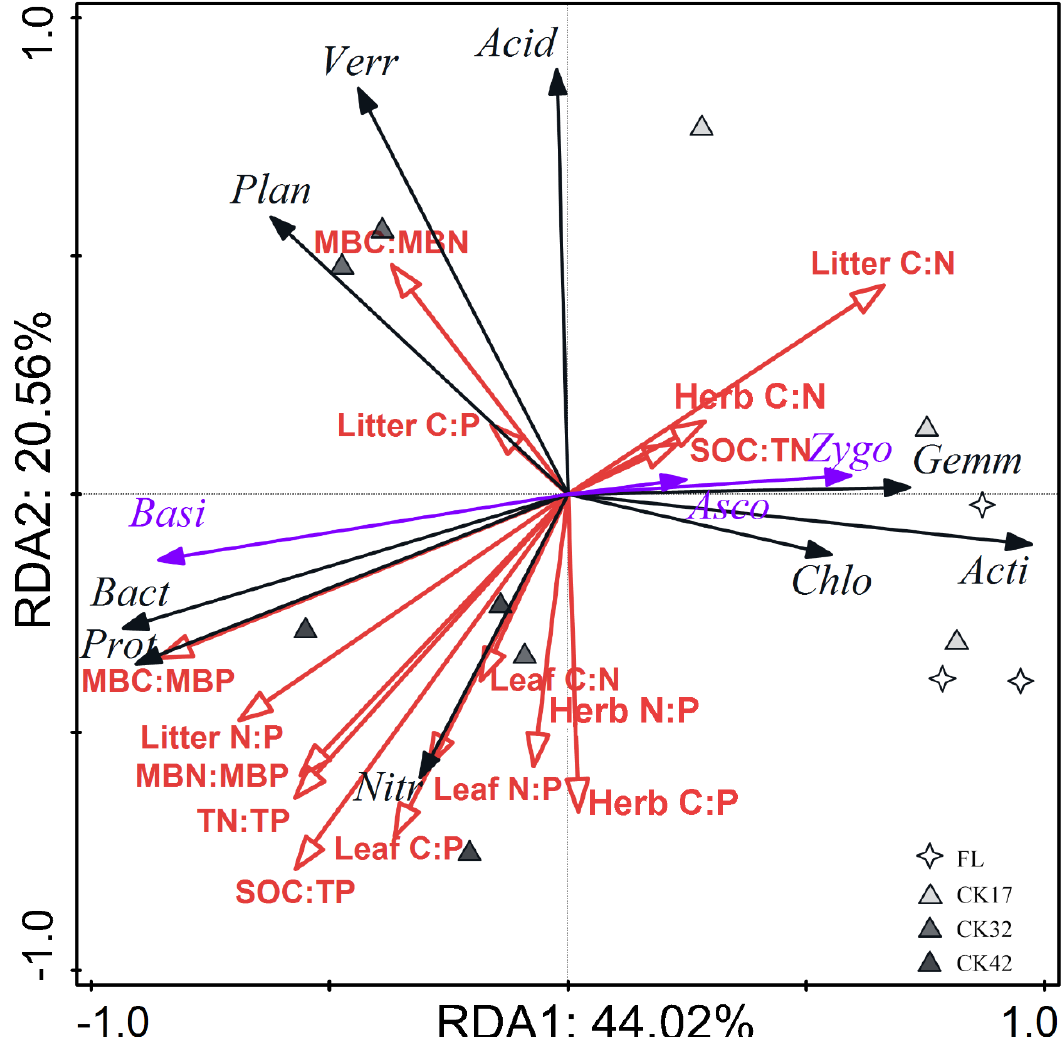
Figure 6. Ordination plots of the results from the redundancy analysis (RDA) to explore the relationships between the C:N:P stoichiometric ratio (red arrows) and the abundance of soil bacterial (black arrows) and fungal (purple arrows) communities at the phylum level. SOC: soil organic carbon; TN: total nitrogen; TP: total phosphorus; MBC: microbial biomass carbon; MBN: microbial biomass nitrogen; MBP: microbial biomass phosphorus. Prot: Proteobacteria ; Acti: Actinobacteria ; Acid: Acidobacteria ; Chlo: Chloroflexi ; Gemm: Gemmatimonadetes ; Nitr: Nitrospirae ; Bact: Bacteroidetes ; Verr: Verrucomicrobia ; Plan: Planctomycetes ; Asco: Ascomycota ; Basi: Basidiomycota ; Zygo: Zygomycota.